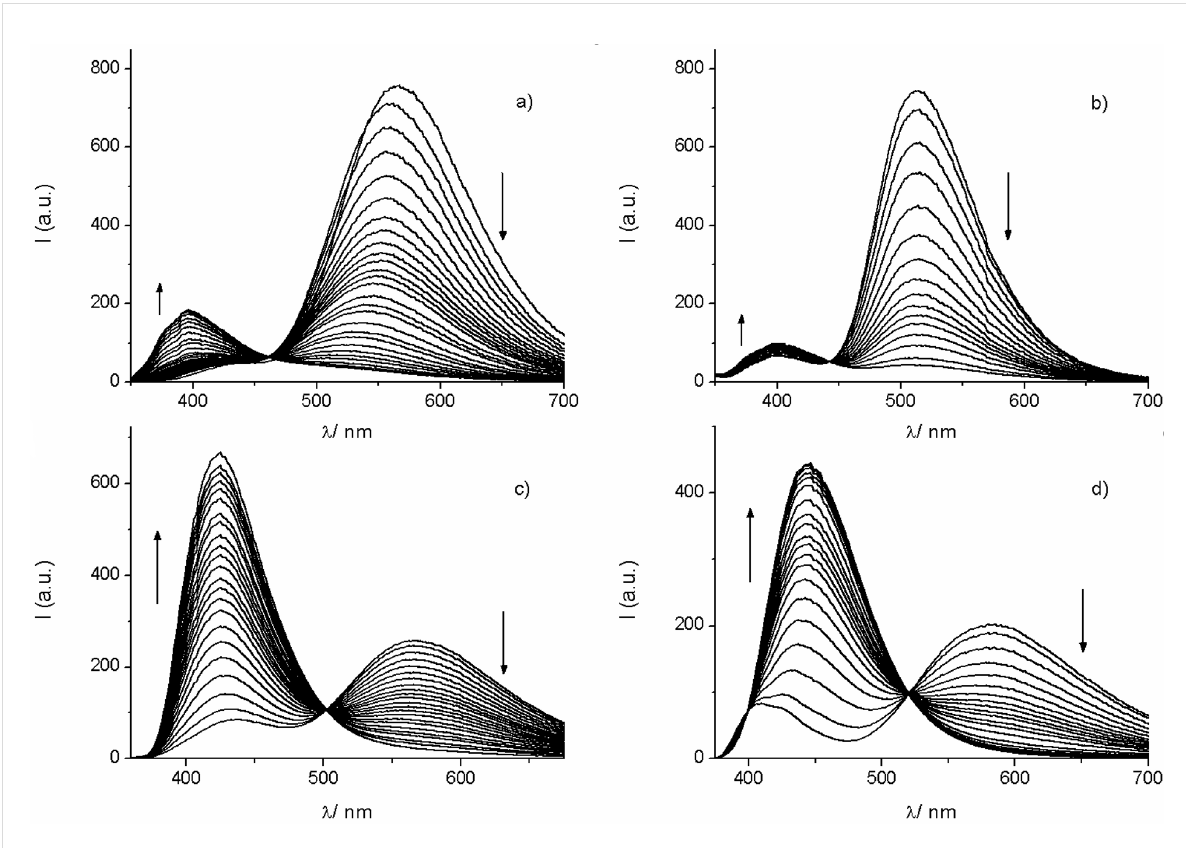
Figure 4: Fluorescence titrations of the dyes (ca. 4–11 μ M) with Bu 4 NF in acetonitrile. a) 16 (up to 156 equiv F − ), b) 17 (up to 40 equiv F − ), c) 18 (up to 152 equiv F − ), d) 19 (up to 100 equiv F − ).